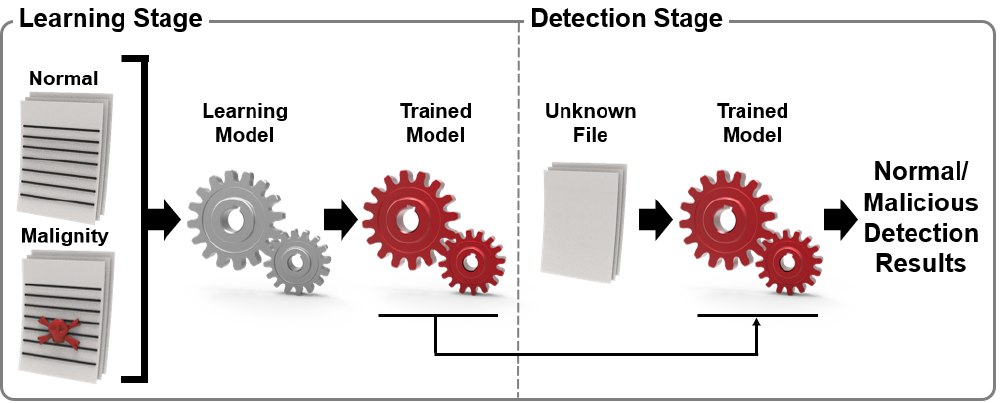
Figure 2. Basic malware detection system using machine learning (ML).